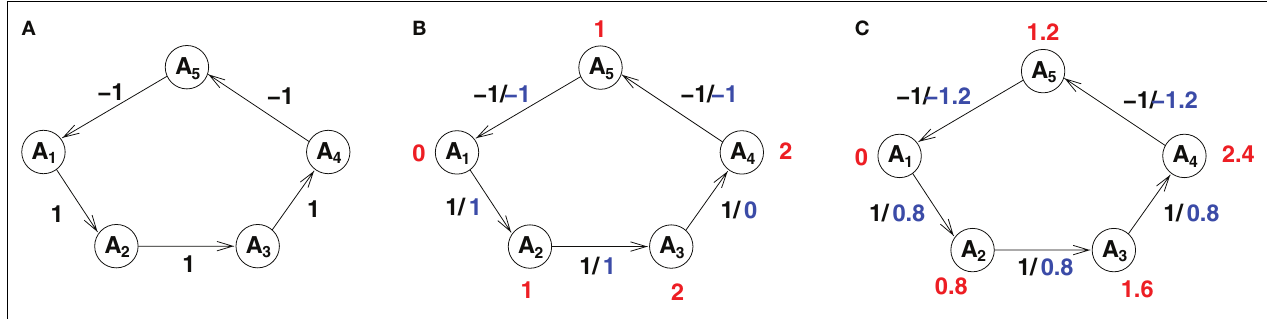
FIGURE 4 | (A) A graph with edge values. (B) One possible hierarchy obtained by optimizing for the number of constraint violations. (C) Another possible hierarchy obtained by optimizing for the maximum deviation. Both (B) and (C) red numbers are the hierarchy levels of nodes, blue numbers the actual distances in the hierarchy.